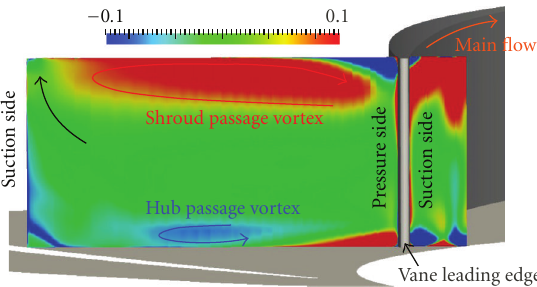
Figure 12: Helicity in a section across di ff user